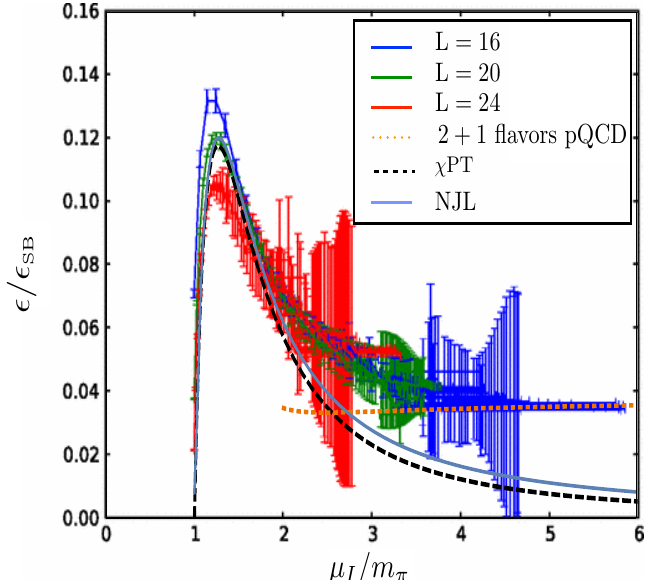
Figure 8. Comparison of the energy density over the Stefan-Boltzmann limit obtained by different methods. We report the lattice data points of the canonical simulations of [76] obtained at T = 20 MeV with three different lattice volumes. The pQCD results of [66] (orange dotted line) indicate a constant asymptotic energy density. The χ PT leading order results of [27] (dashed black line) and the mean field NJL results (solid blue line), see [38,49], perfectly reproduce the peak structure at µ I